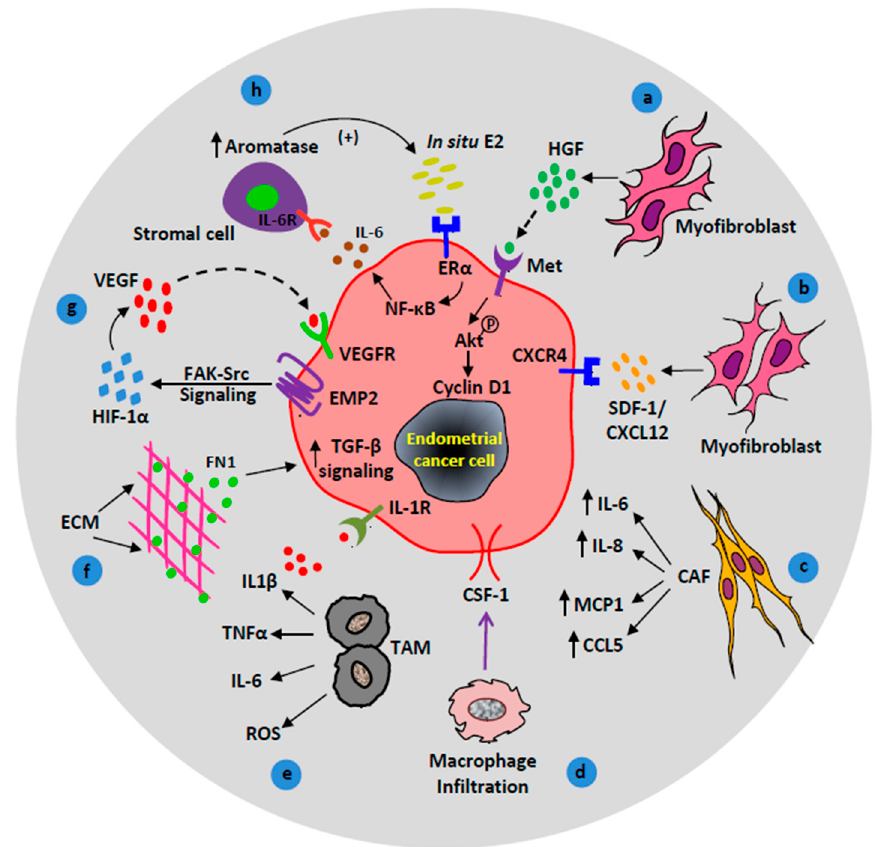
Figure 2. Contributions of activated/recruited stromal cells in endometrial cancer (EC) progression. ( a ) Hepatocyte growth factor (HGF) stimulates proliferation of EC cells via the HGF/c-MET/AKT signaling pathway. ( b ) Myofibroblasts promote tumor growth via CXCR4/CXCL12 signaling axis. ( c ) Cancer-associated fibroblasts (CAF) secrete cytokines (IL-6, IL-8, and MCP-1) and chemokines (CCL5/RANTES) to promote cancer progression. ( d ) Macrophage response, colony-stimulating factor 1 (CSF1) signals macrophage infiltration to the endometrial reactive stroma. ( e )